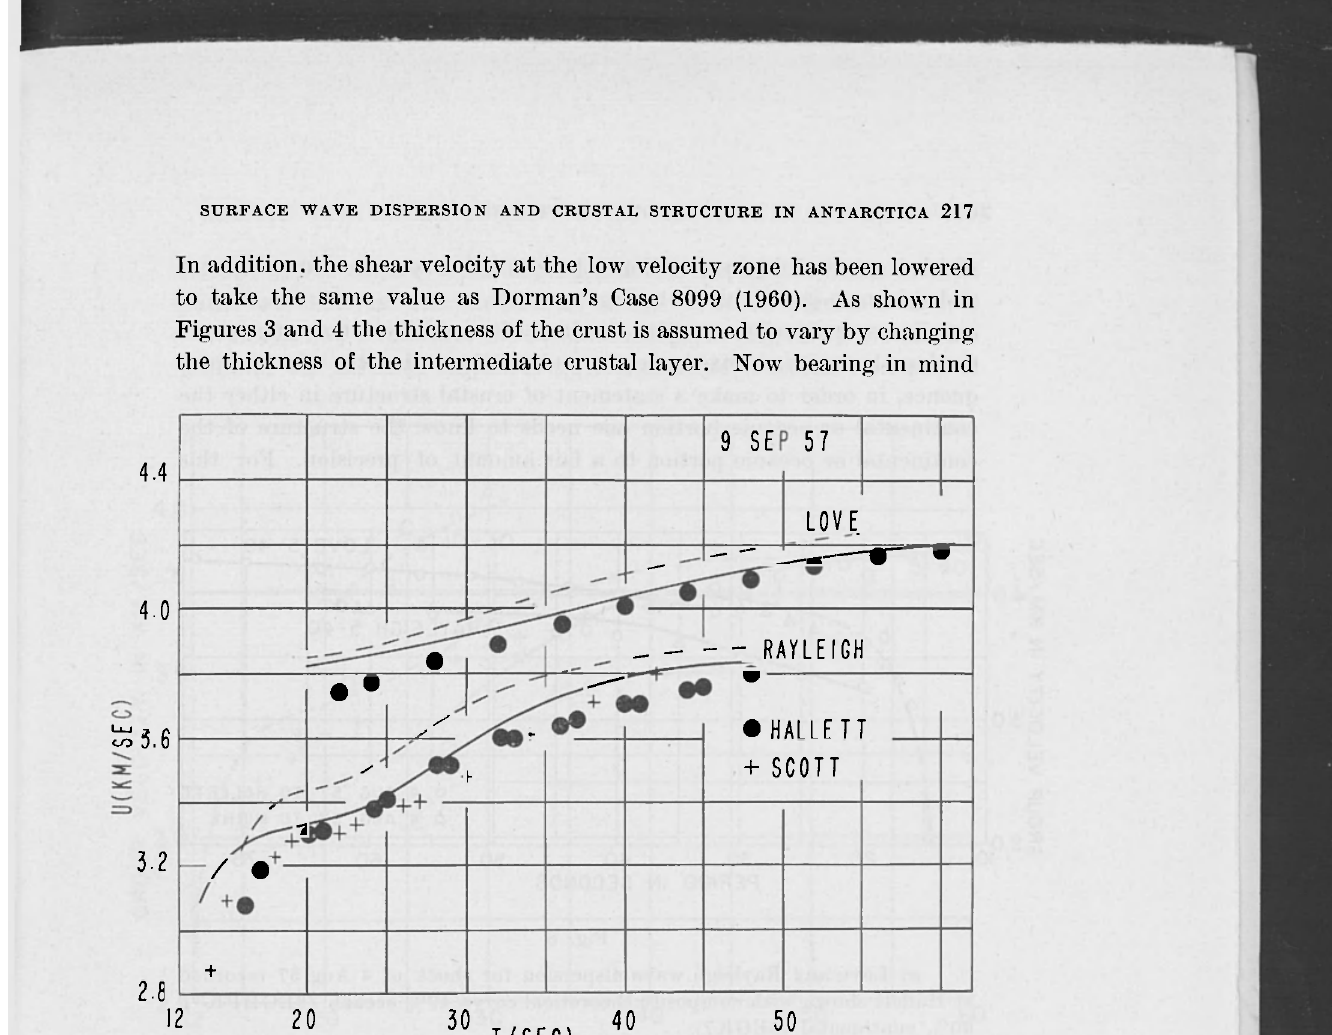
7 - Love and Rayleigh wave dispersion for shock of 9 Sept. 57 recor- ded at Hallett and Scott Base shown with composite theoretical curves for a 50% oceanic (6EGHPK") and 50% continental (6EGK7) path. Solid line 5 km oceanic crust 40 km continental crust; dashed line 5 km oceanic crust 35 km continental